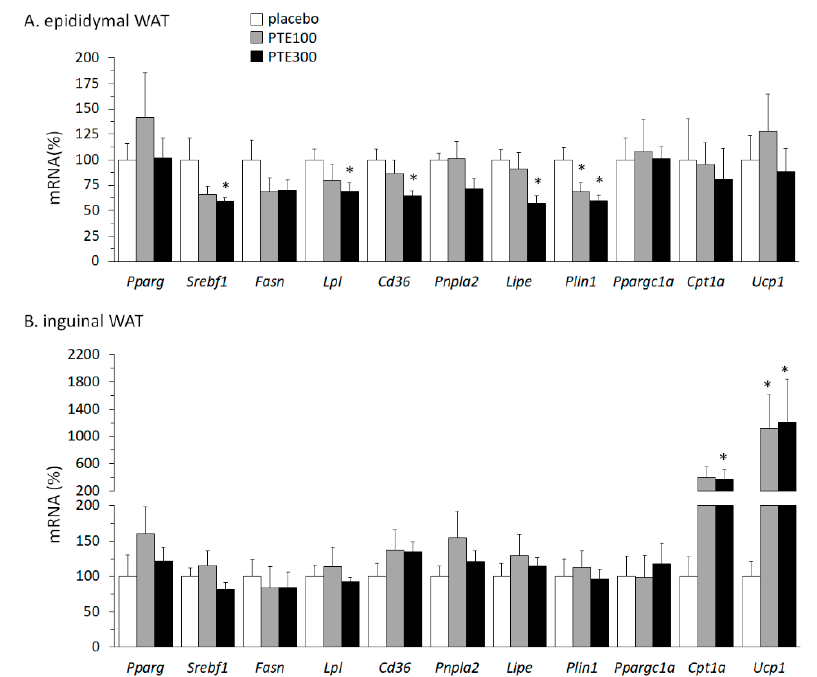
Figure 3. Phaeodactylum tricornutum ethanolic extract (PTE) down-regulates fatty acid uptake and lipid turnover capacities in epididymal white adipose tissue (eWAT) and increases oxidative/thermogenic capacity in inguinal WAT (iWAT) of C57BL/6J mice fed with a high fat diet (HFD). mRNA levels of selected genes as indicated were analyzed in eWAT ( A ) and iWAT ( B ) at the end of the experiment. HFD-fed mice received daily an oral dose of PTE (100 mg or 300mg/kg body weight) or placebo (olive oil:water, 2:1, v : v ) for 26 days. Data are the mean ± SEM of 5–6 male mice/group and are expressed relative to the mean value of the vehicle group, which was set to 100. To compare between two groups, the non-parametric Mann–Whitney U test was used: *, different ( p < 0.05) from vehicle.